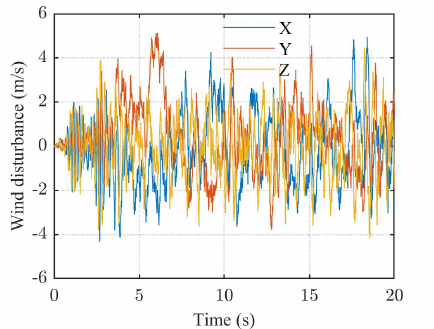
Figure 11. Airflow speed in body coordinates.